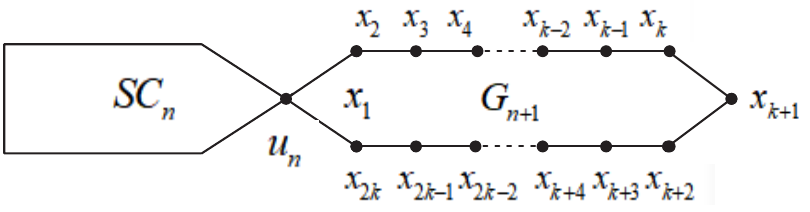
Figure 1. A regular polygonal chain SC n + 1 with n + 1 regular